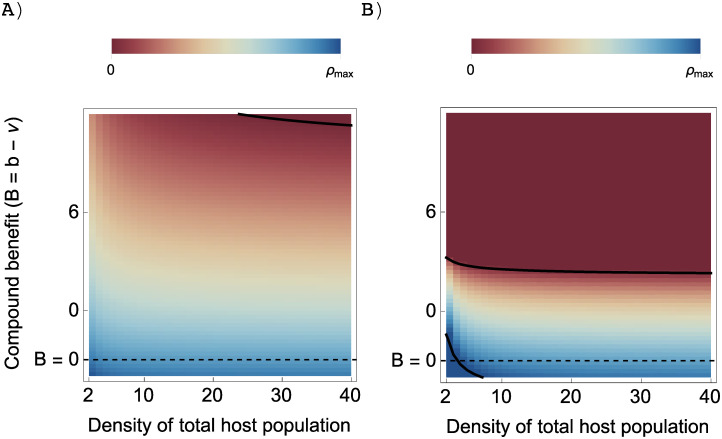
Effect of the compound benefit B and density of the total host population N on the transition from fully retaining independent reproduction (ρ = ρmax) to completely forgoing independent reproduction (ρ = 0) under cases with no vertical transmission (σ = 0).Trade-off is as in Fig 3. A) Convex trade-off curve where α = 0.7, δ = 1.3, B) concave trade-off curve where α = 3.1, δ = 1.3. The dashed line corresponds to the case when the symbionts gain no benefit (b = 0). The thick lines separate the three regions: pure free-living (dark blue), obligate symbiosis (dark red) and faculative symbiosis with varying degrees of independent reproduction.